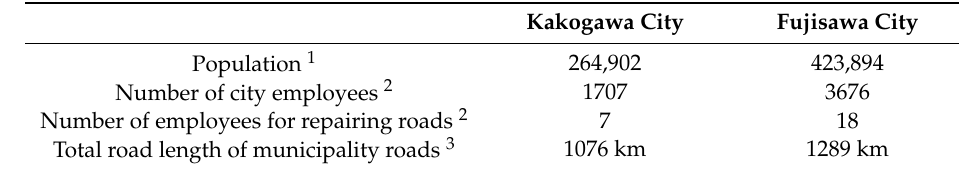
Figure 1. Location of the study area (Background map: OpenStreetMap). Table 1. Information of study area.